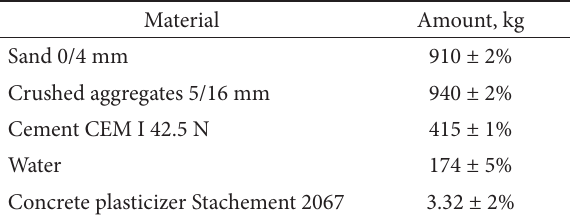
Table 3. Concrete mix proportions